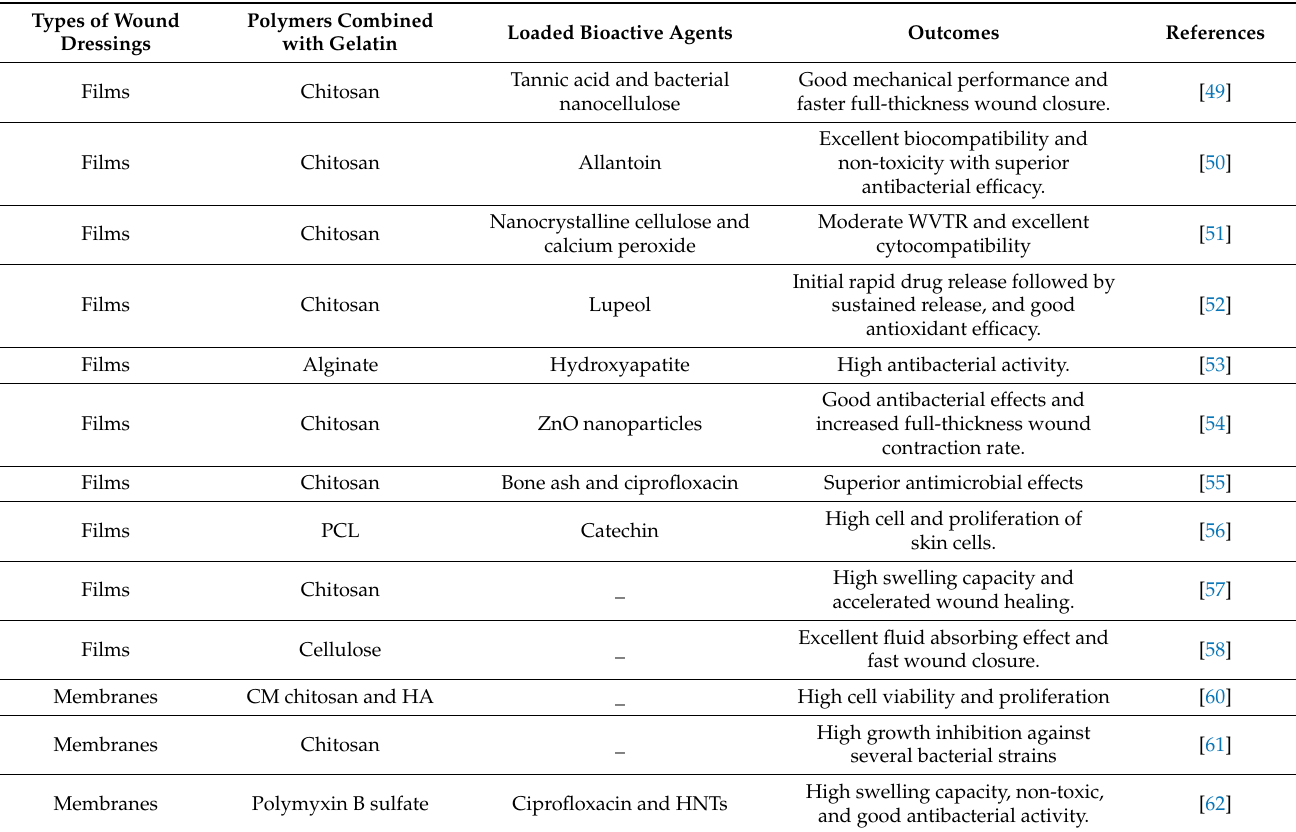
Table 2. Summary of Gelatin-based Hybrid Film and Membrane Wound